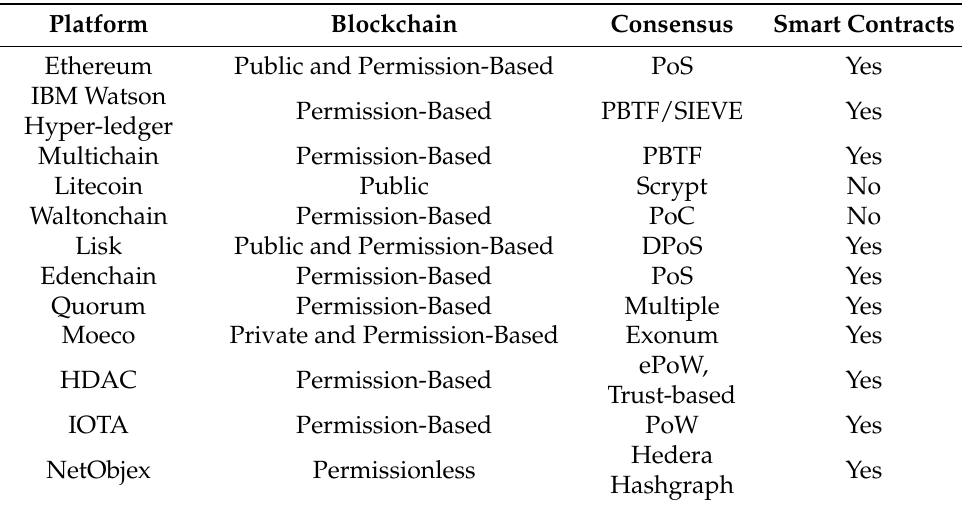
Table 4. Blockchain methodologies for designing IoE